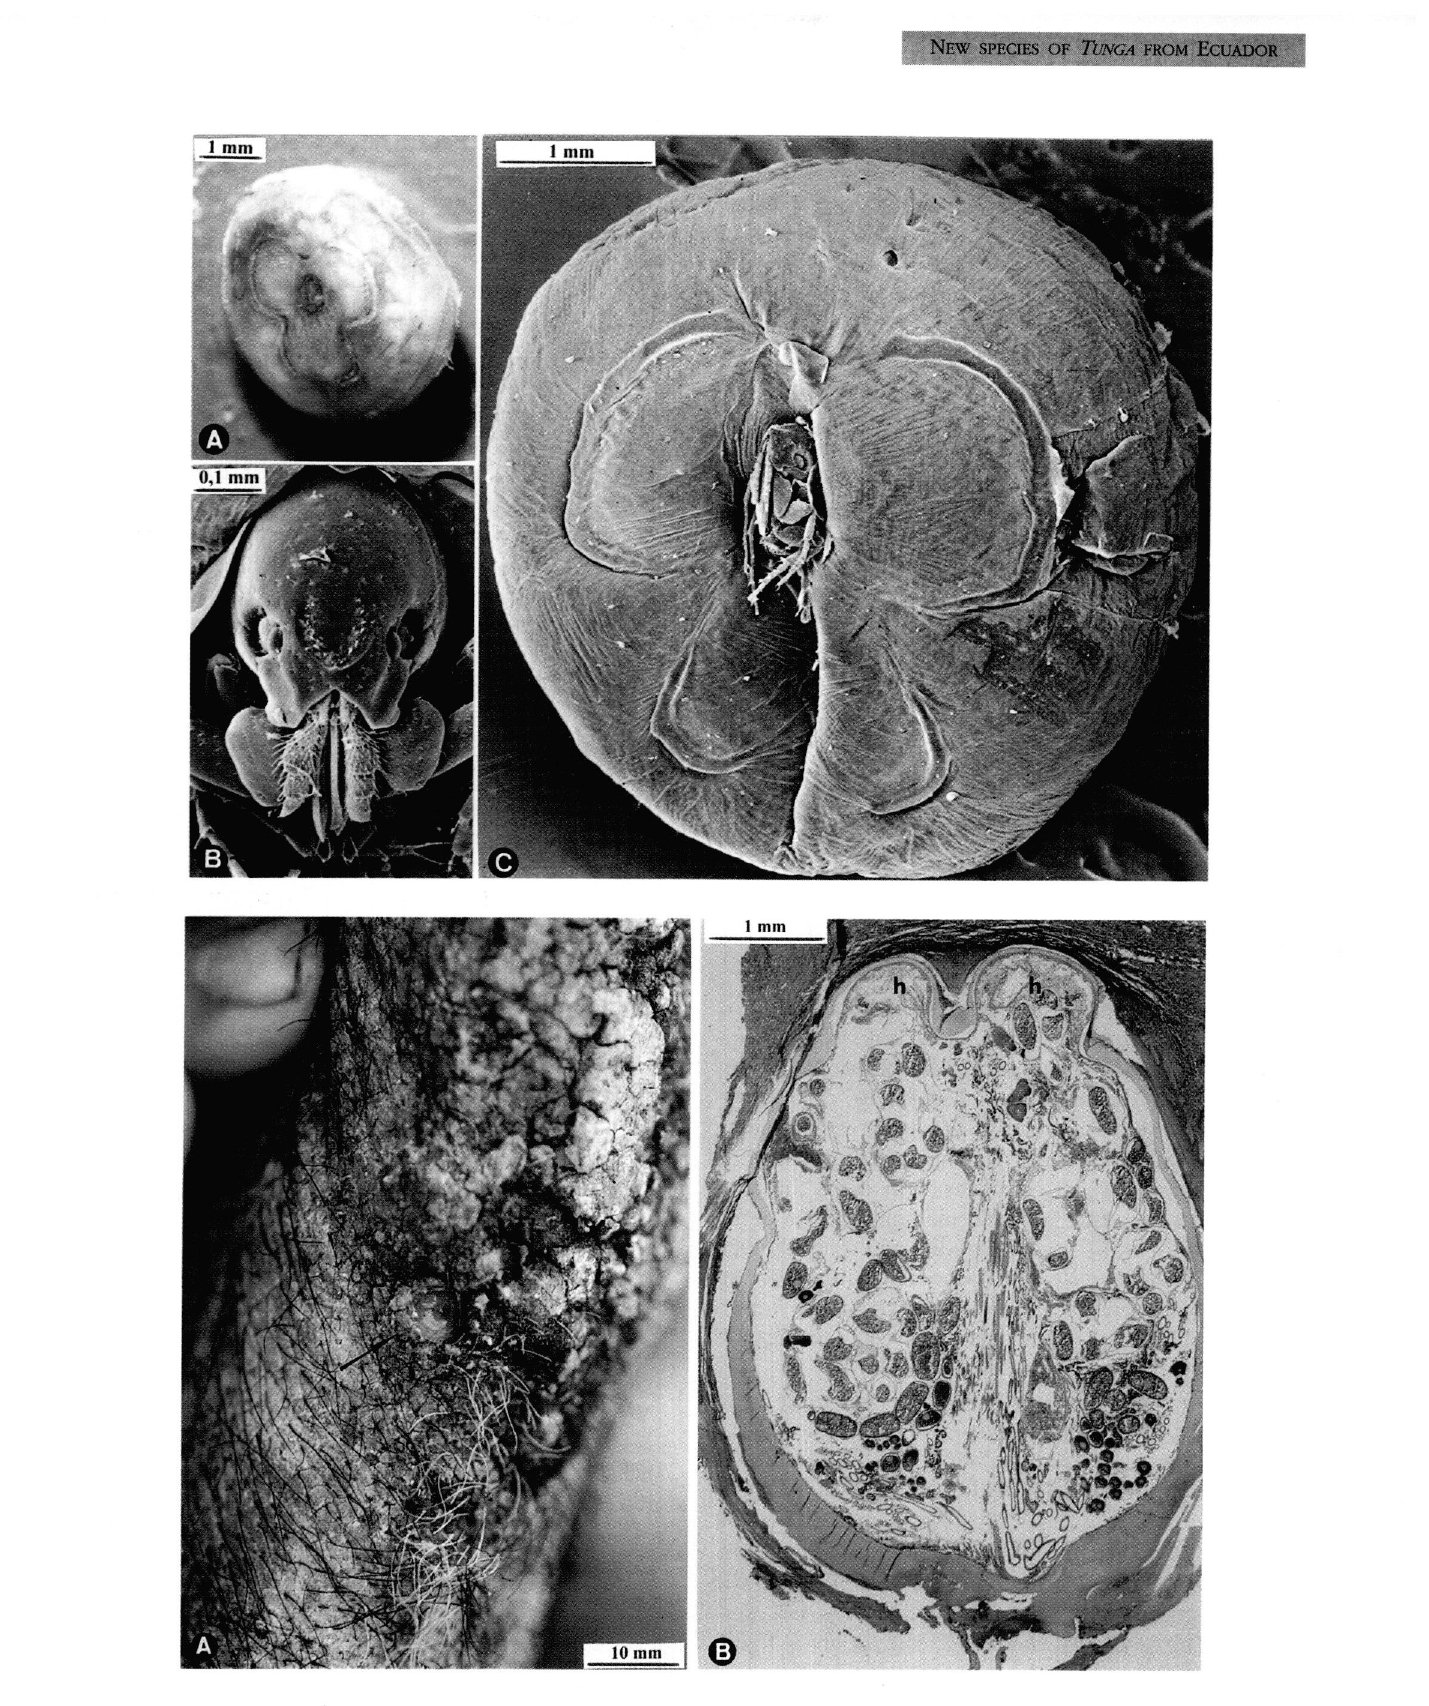
Parasite, 2003, 10, 9-15